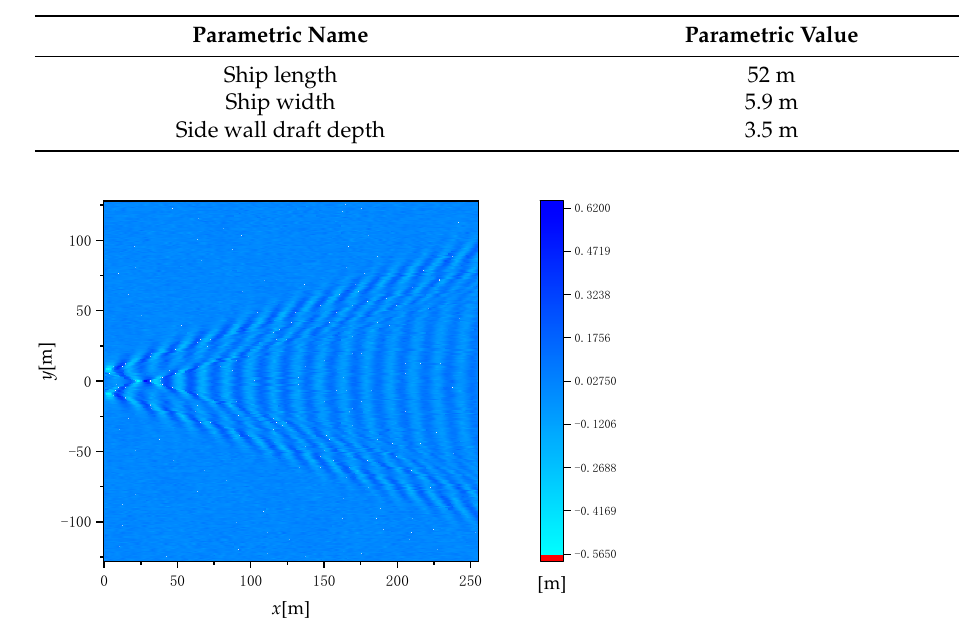
Figure 3. Wave height of the time-varying Kelvin wake.